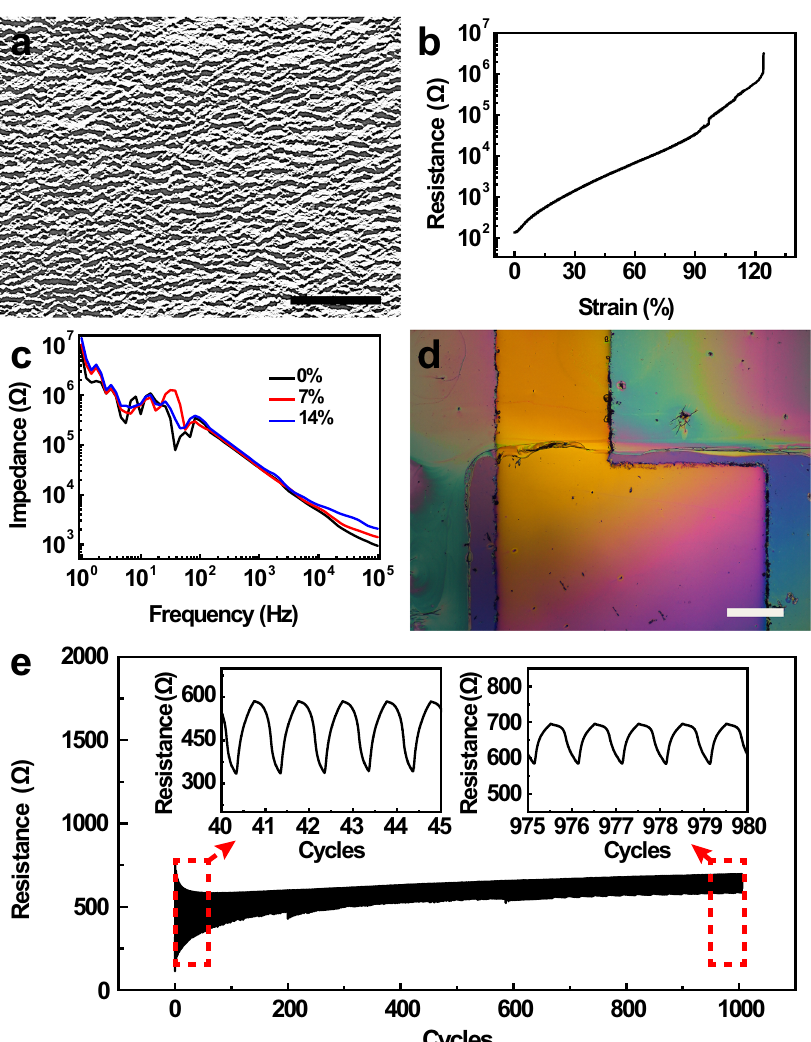
Fig. 4 Characterization of electrode. a SEM image of the electrode surface. b Stretchability of the electrode. c Impedances of the electrode under different degrees of stretching. d Encapsulation of the electrode. e Resistance change of the electrode after being stretched to 30% for 1000